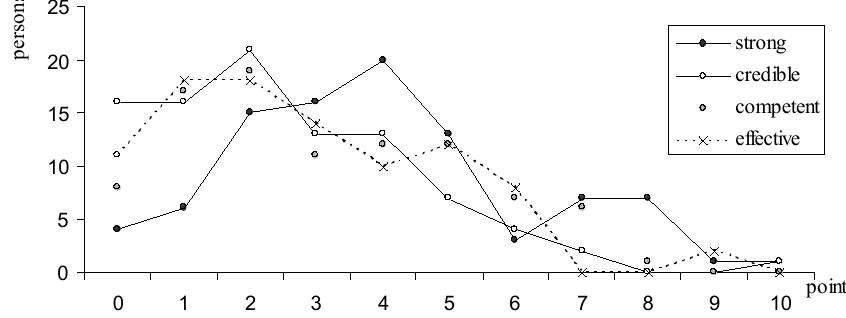
Fig 1. Students’ evaluation of the state